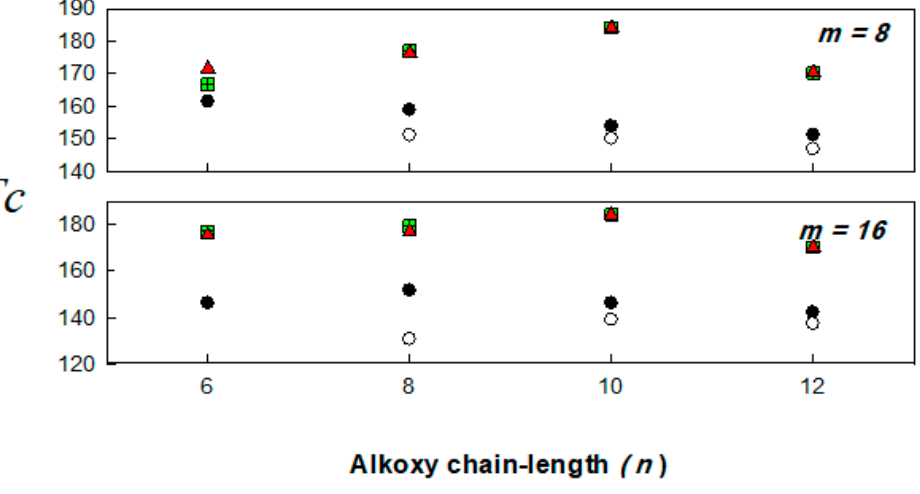
Figure 4. Dependence of the stability temperature ( T c) on the terminal alkoxy chain length ( n ) substituent of the acid moiety; I n /II m ( ▲ ); I n /III m ( ); IV n /II m (●); IV n /III m ( ○ ).